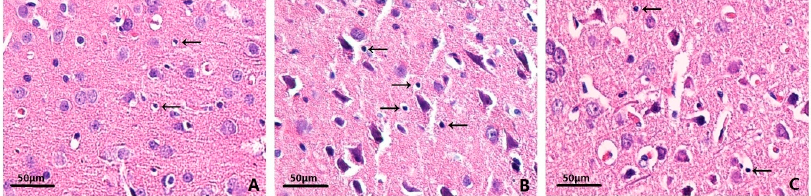
Figure 2. The morphological and structural changes of neurons in different groups, by HE staining, magnification 400×, scale bar = 50 µm. ( A ) Sham-operated group; ( B ) ICH group; ( C ) MIHA group; (arrows) denatured cells. Table 3. The denatured cell indexs (DCIs) s in different groups shown by hematoxylin–eosin (HE) staining 72 h after intracereral hemorrhage (ICH) ( x ± s).